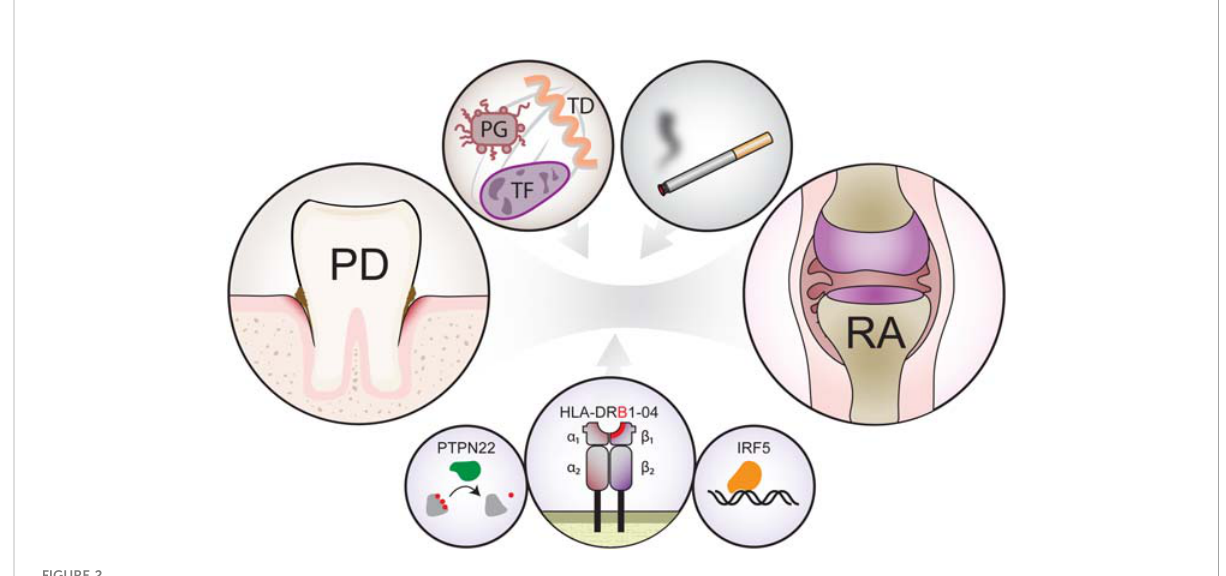
FIGURE 2 Shared risk factors that contribute to development of periodontal disease (left circle, PD) and rheumatoid arthritis (right circle, RA). The top left circle shows bacteria forming the “ red complex ” , namely, Porphyromonas gingivalis (red, PG), Tannerella forsythia (violet, TF) and Treponema denticola (orange, TD) and the top right circle shows an environmental factor (smoking). Bottom three circles show the main genetic risk factors, namely shared epitopes within the b -chain of human leukocyte antigen (HLA), tyrosine phosphatase (PTPN22) and Interferon Regulatory Factor 5